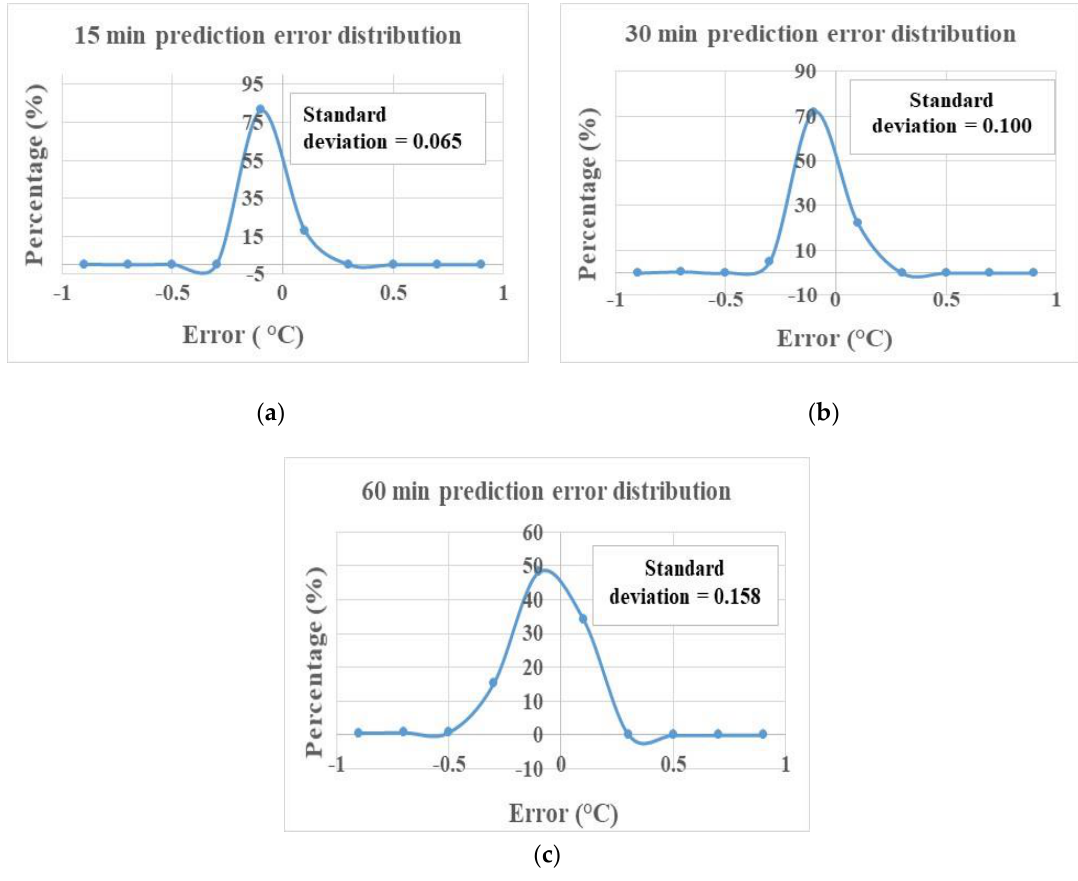
Figure 4. Error distribution for experiment A-order 1: ( a ) 15 min prediction; ( b ) 30 min prediction ( c ) 60 min prediction.